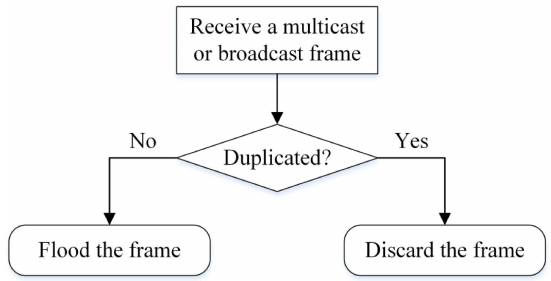
Figure 11. The process of forwarding multicast/broadcast frames at